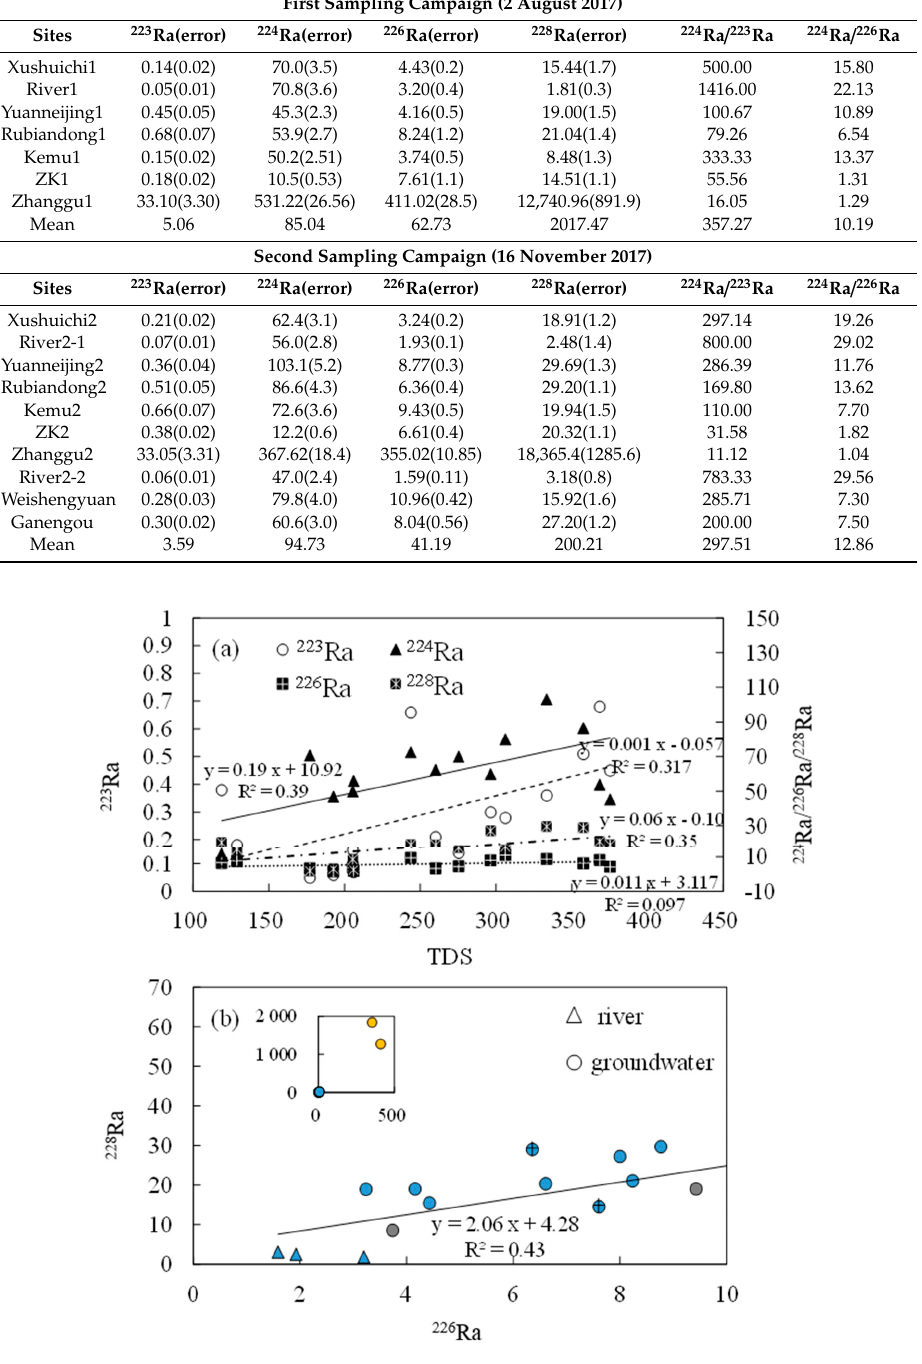
Figure 4. ( a ) Relationship between the activity concentrations of four natural radium isotopes and TDS in the water samples, excluding the hot spring at Zhanggu which contains extremely high salinity and radium contents. ( b ) Activity concentration of 228 Ra as a function of the activity concentration of 226 Ra. Triangles are river samples, circles are groundwater samples, and circles with a cross are the water samples at the borehole ZK. Yellow represents the spring at Zhanggu, grey represents the spring at Kemu, and blue represents the rest.